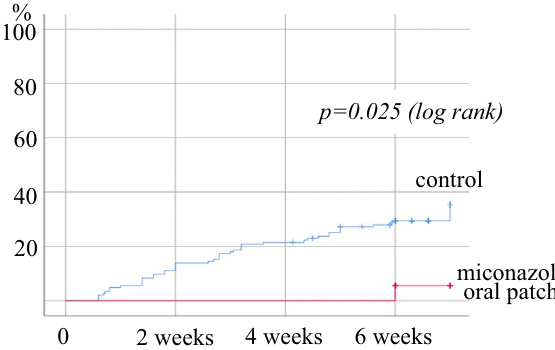
Figure 1. Relationship between the administration of miconazole mucoadhesive tablets and the development of oral candidiasis.